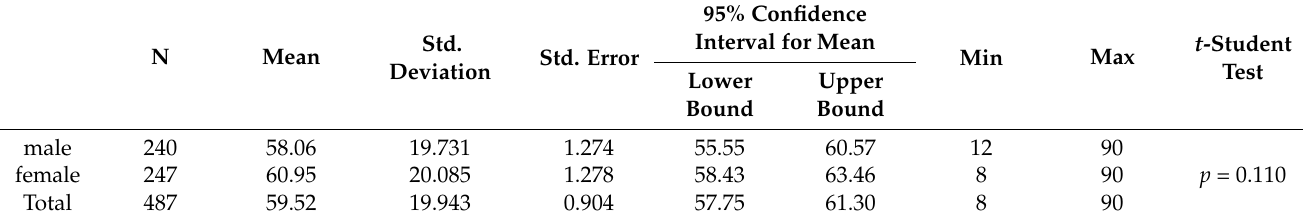
Table 2. Average age compared by gender.